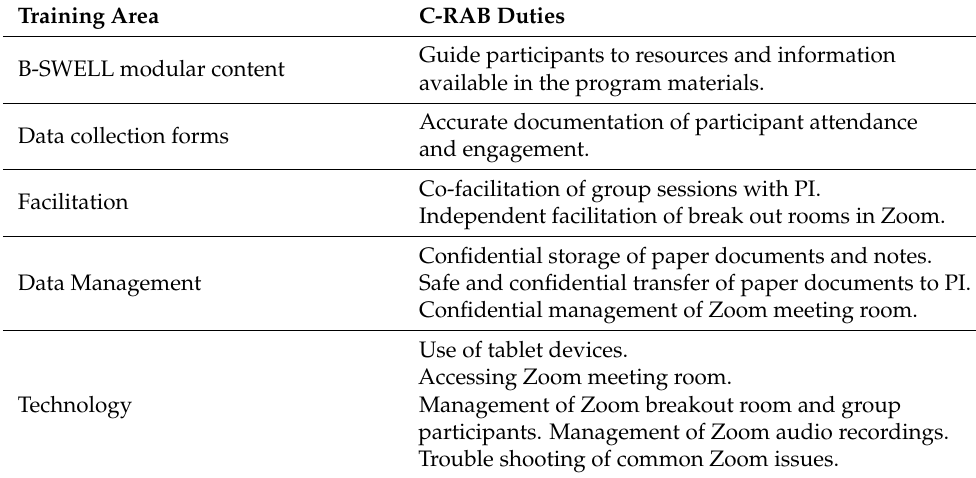
Table 3. C-RAB facilitator training and corresponding duties.